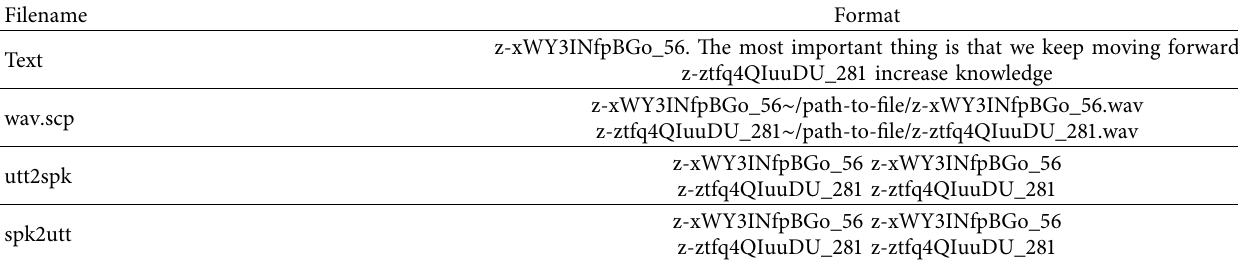
Table 2: The format of Kaldi ASR